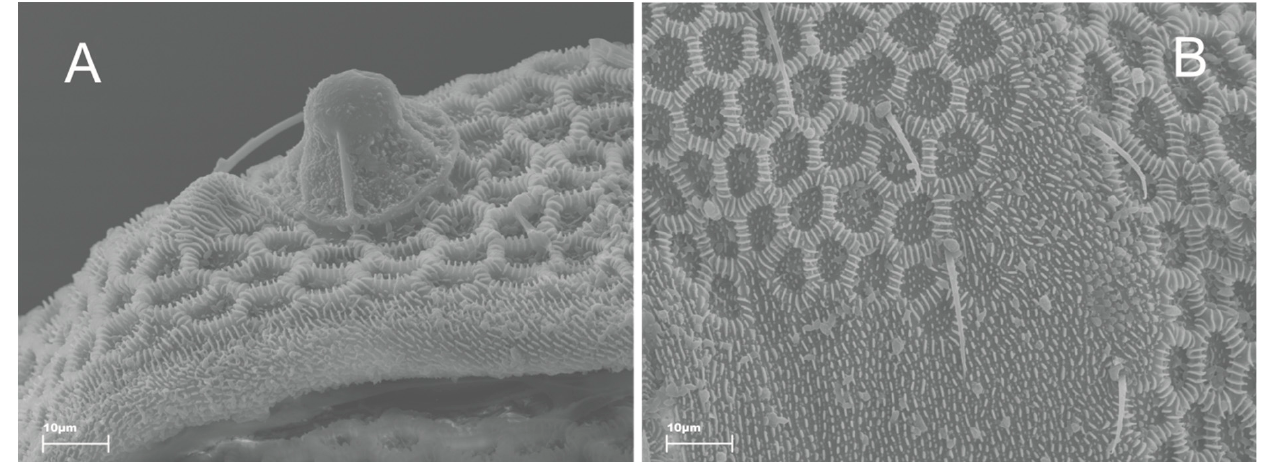
Figure 5. Male of L. luteum : ( A )—gland-like organs and side eye; ( B )—different body surface sculpture (polygonal and striate surface sculpture). SEM observations.